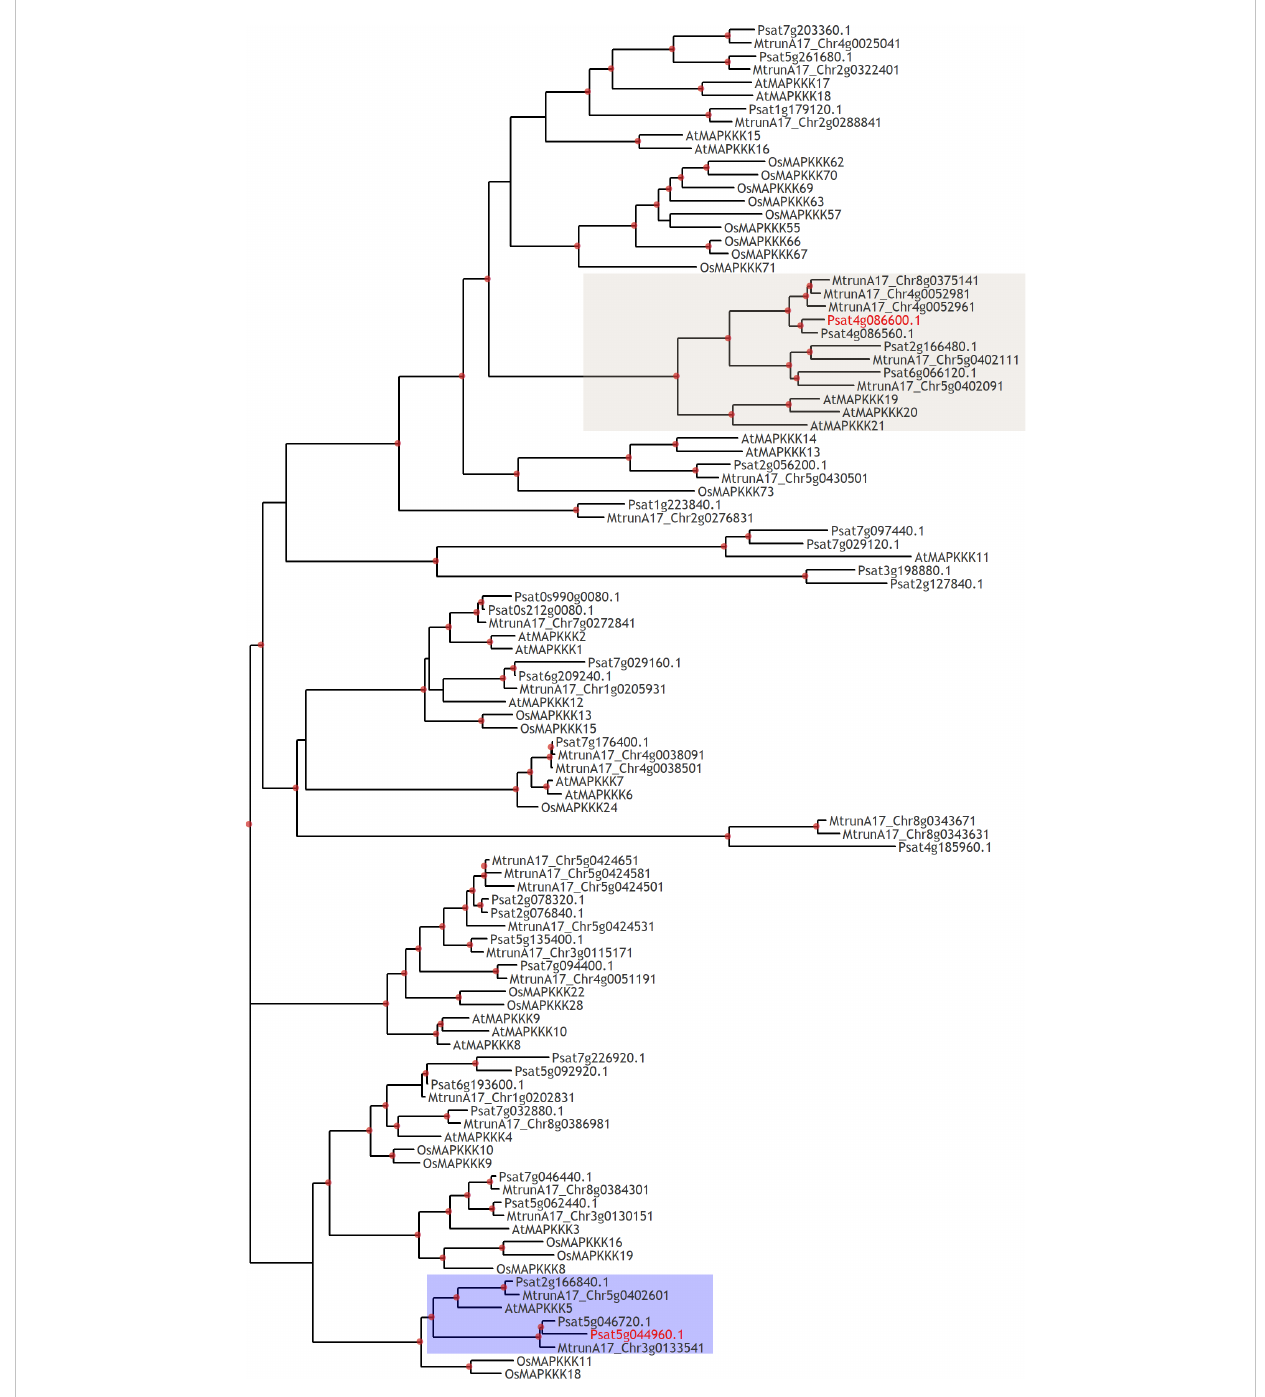
FIGURE 5 Phylogenetic tree constructed by the Maximum Likelihood method based on amino acid sequences of MAPKKKs from Arabidopsis thaliana , rice Oryza sativa and legumes: Medicago truncatula , Pisum sativum . Red dots indicate branch support more than 80 based on 1000 bootstrap replicates. Red labels show genome identi fi ers of PsMAPKKK5 (Psat5g044960) and PsMAPKKK20